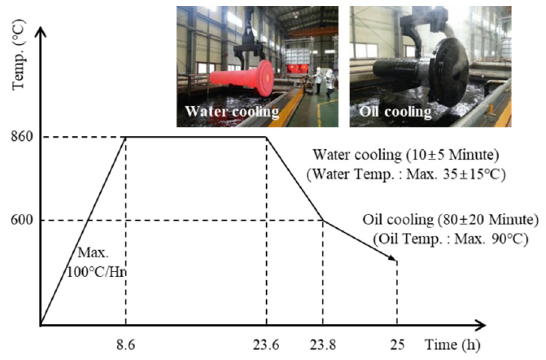
cogging and necking.